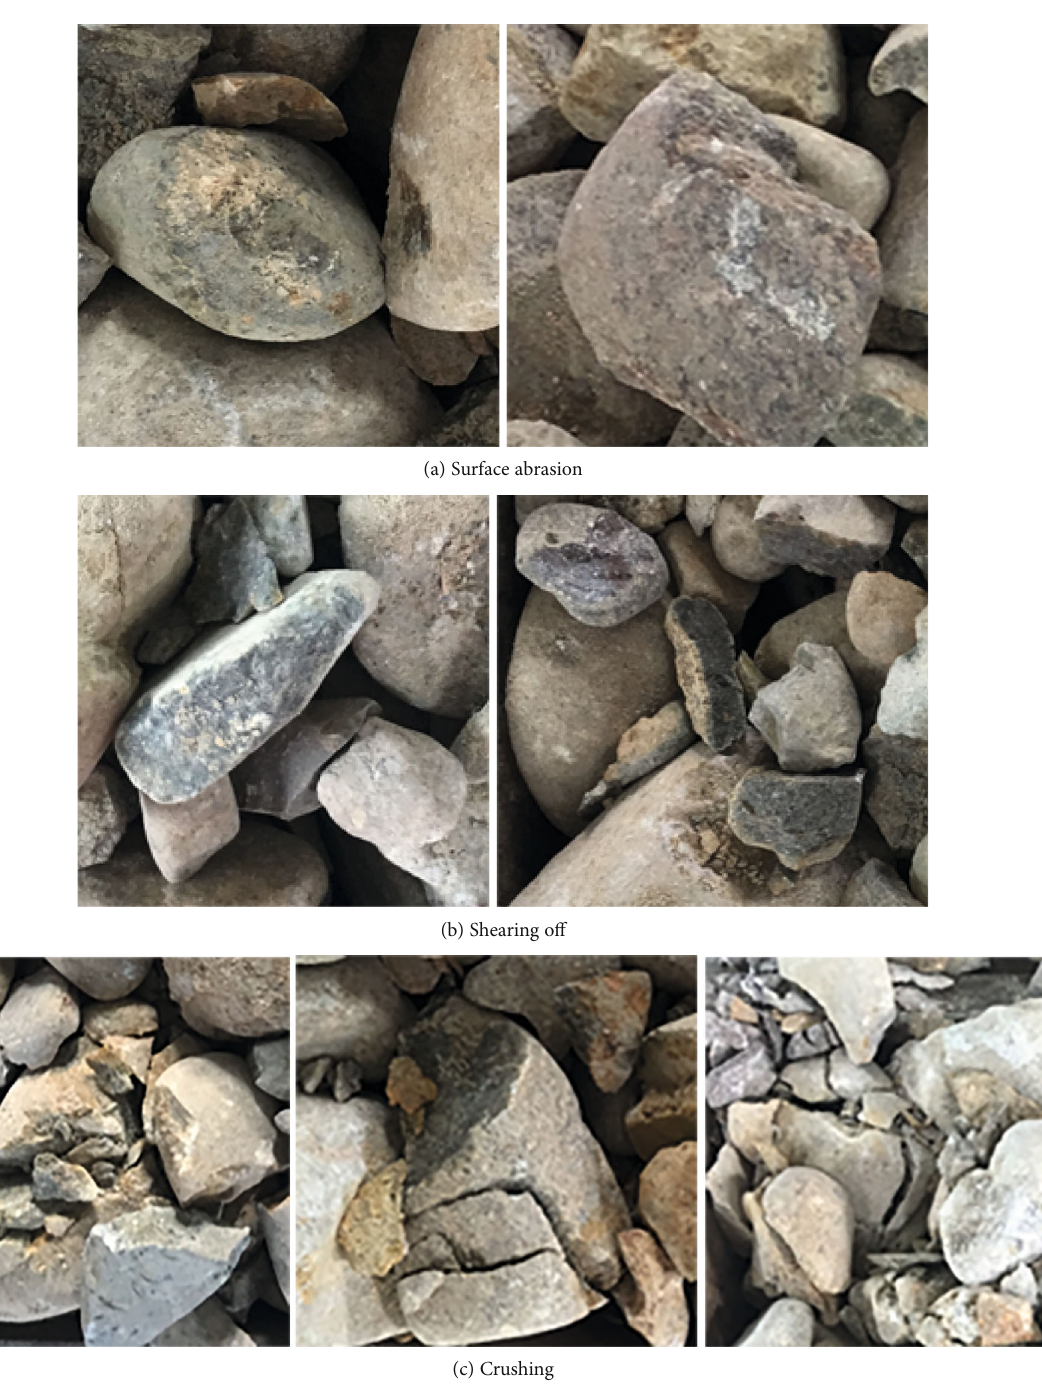
Figure 9: Shear failure of coarse